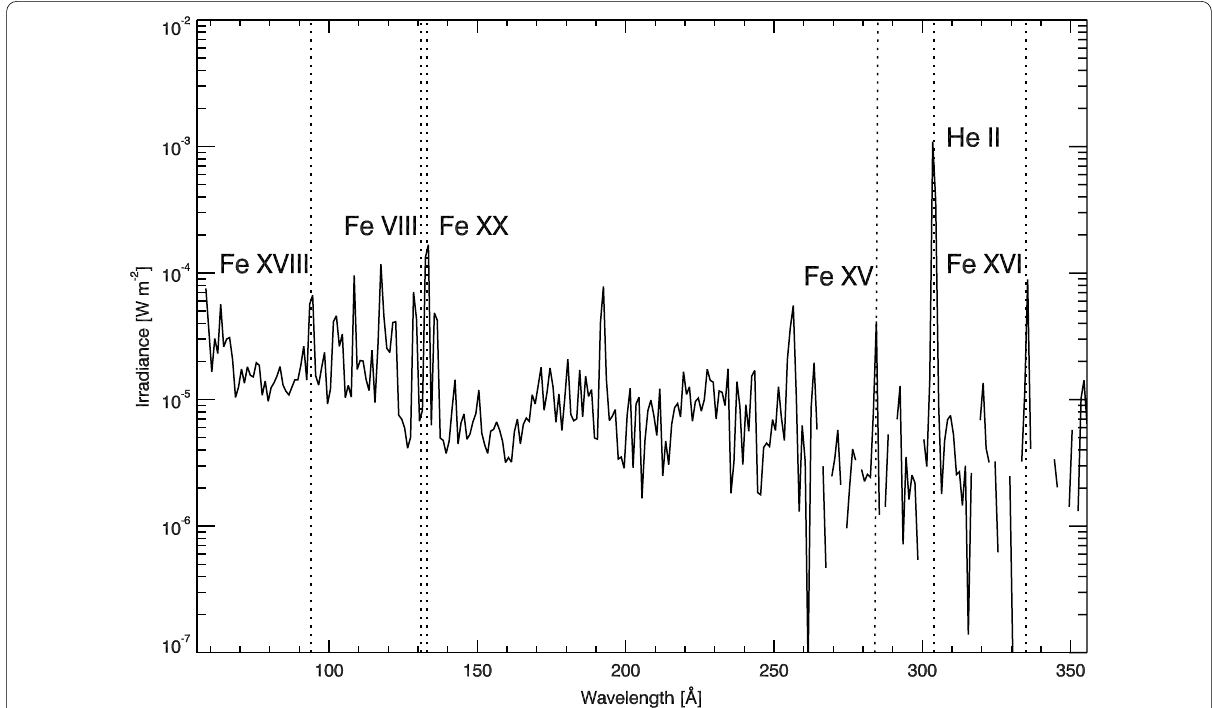
Fig. 2 Example of EUV spectrum observation. The EUV spectrum at the GOES/XRS-B peak time (18:52 UT) was observed by the SDO/EVE MEGS-A for the M9.9-class flare on January 1, 2014. This EUV spectrum is subtracted non-enhanced value (at 18:00 UT) from the value of each wavelength before the flare as the background. The EUV flare lines focused on in this study are indicated by vertical dotted